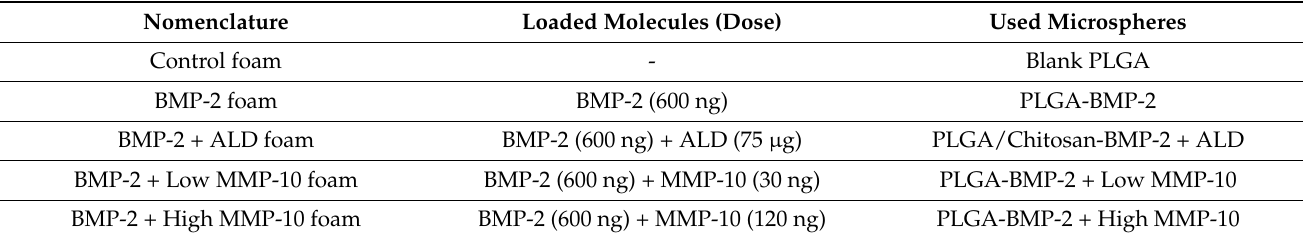
Table 2. Developed cross-linked chitosan foams and their correspondent final drug amount adjusted by microsphere drug